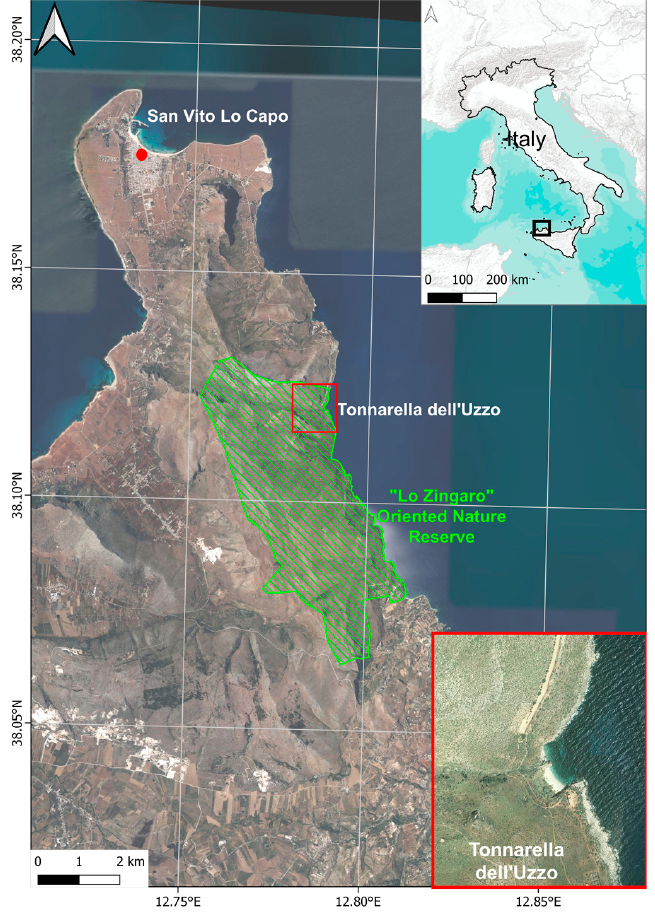
Figure 1. Location map of the study area.